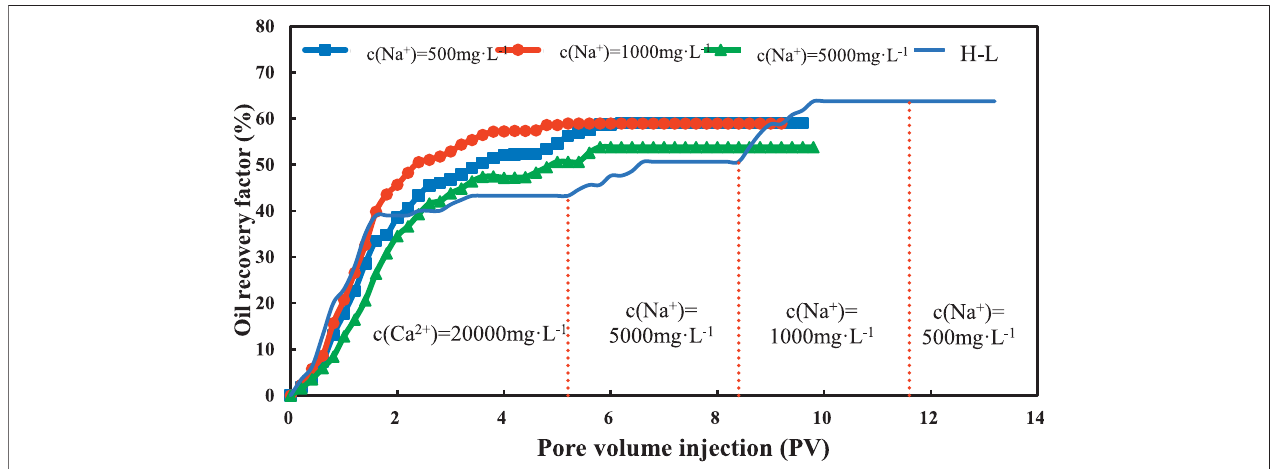
FIGURE 12 | Variation curve of the recovery degree of kaolinite sand packs under different displacement methods.